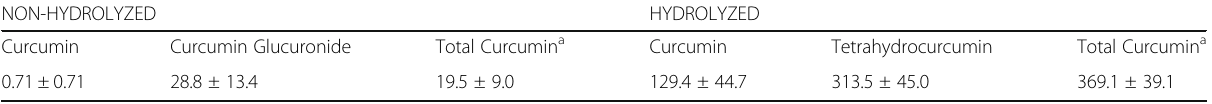
Table 2 C max ± SEM (ng/mL) for human plasma samples from 8 subjects that were assayed with and without enzymatic hydrolysis